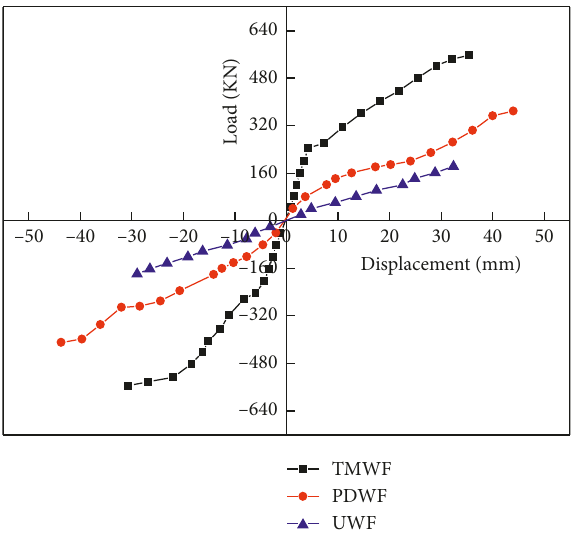
Figure 11: Skeleton curve.